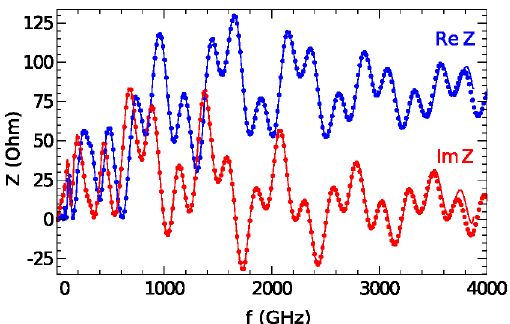
FIG. 2. Collimator impedance: present theory is shown with solid line, the result of simulations with ECHO are shown with dots.